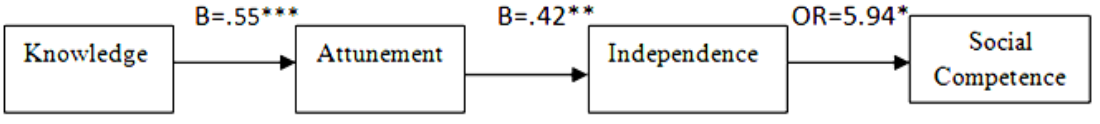
Figure 1. Results of path analysis for social competence . Note: For linear regression of knowledge of infant development on parental attunement R 2 = 0.30 (R 2 For linear regression of parental attunement on power/independence R 2 = 0.17 (R 2 p ≤ 0.01. For logistic regression of power/independence on social/emotional cutoff (binary) Nagelkerke R 2 = 0.19, p ≤ 0.05; odds ratio: (OR) = 5.94, p ≤ 0.05); * p ≤ 0.05, ** p ≤ 0.01, *** p ≤